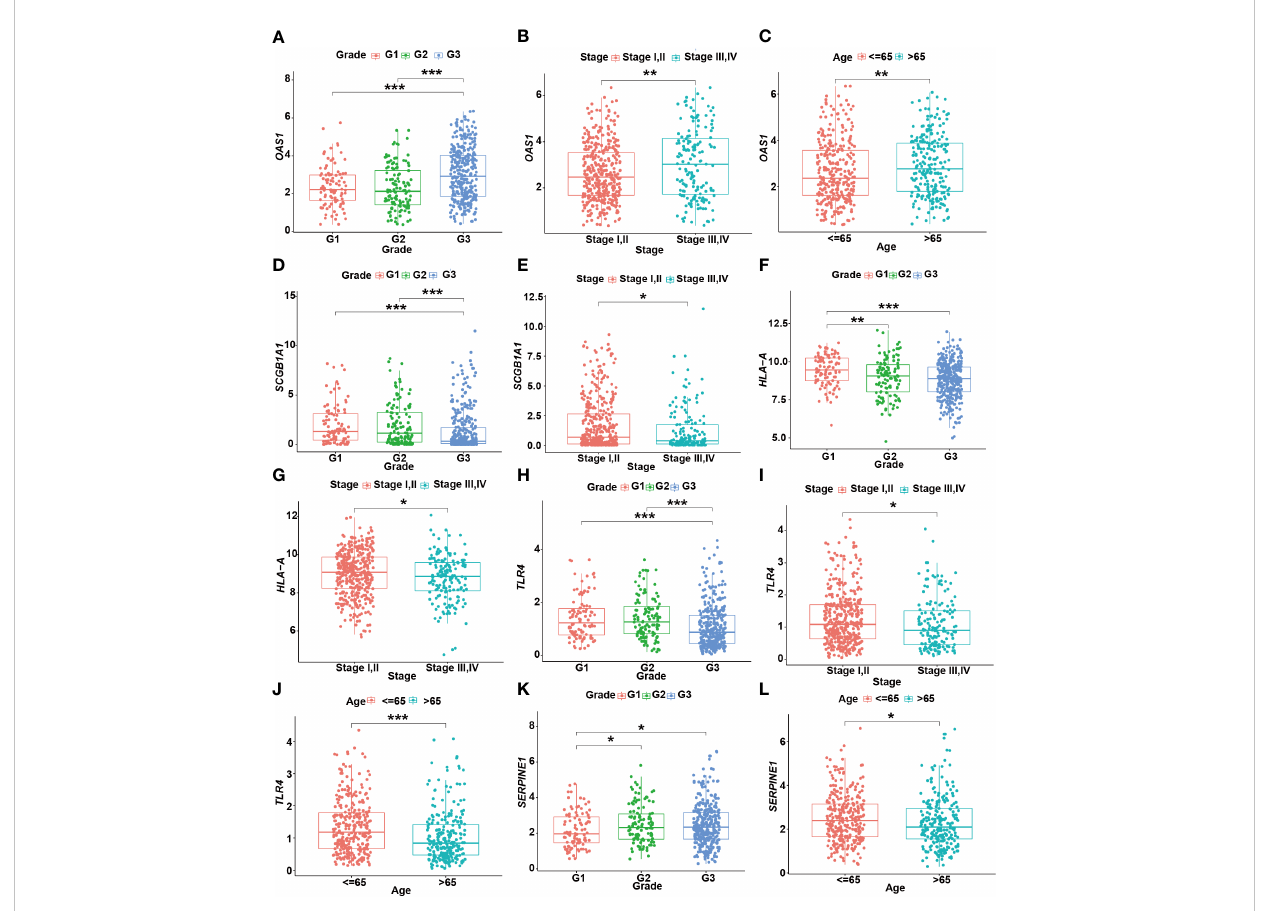
FIGURE 8 The relationship between prognostic gene levels and clinical characteristics. The relationship between the expression of OAS1 and grade (A) , stage (B) , and age (C) of UCEC patients. The relationship between the expression of SCGB1A1 and grade (D) , stage (E) of UCEC patients. The relationship between the expression of HLA-A and grade (F) , stage (G) of UCEC patients. The relationship between the expression of TLR4 and grade (H) , stage (I) , and age (J) of UCEC patients. The relationship between the expression of SERPINE1 and grade (K) , age (L) of UCEC patients. * means P < 0.05; ** means P < 0.01; *** means P < 0.001.